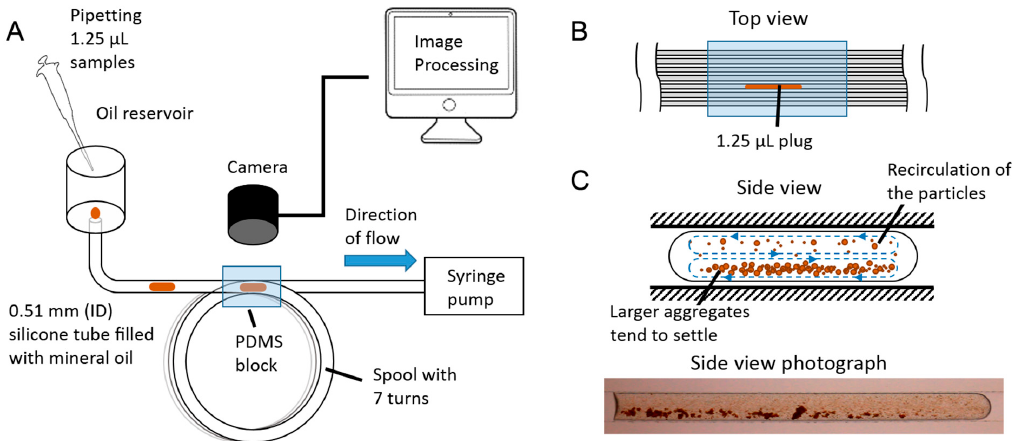
Figure 1. ( A ) Schematic of the continuous high-throughput microfluidic system. The assays are introduced in 1.25-µL volumes into a 0.51-mm internal diameter silicone tube of 2 m in length through an open oil reservoir. The entire tube is filled with mineral oil, which is continuously drawn from the reservoir by a syringe pump connected at the opposite end. The tube is coiled around a spool, and seven observation windows have been created by casting a polydimethylsiloxane (PDMS) block, which provides refractive index matching with the material of the tube. The length of each turn in the coil is 30 cm. A camera has been positioned above the observation windows, enabling us to capture the passage of the assay through the tube at regular intervals. ( B ) Top view of the PDMS block, illustrating a plug traveling through an observation window. The field of view of the camera is 9.7 × 9.7 mm. ( C ) Side view diagram and photograph of an assay, indicating recirculation patterns and microbead aggregate behavior.